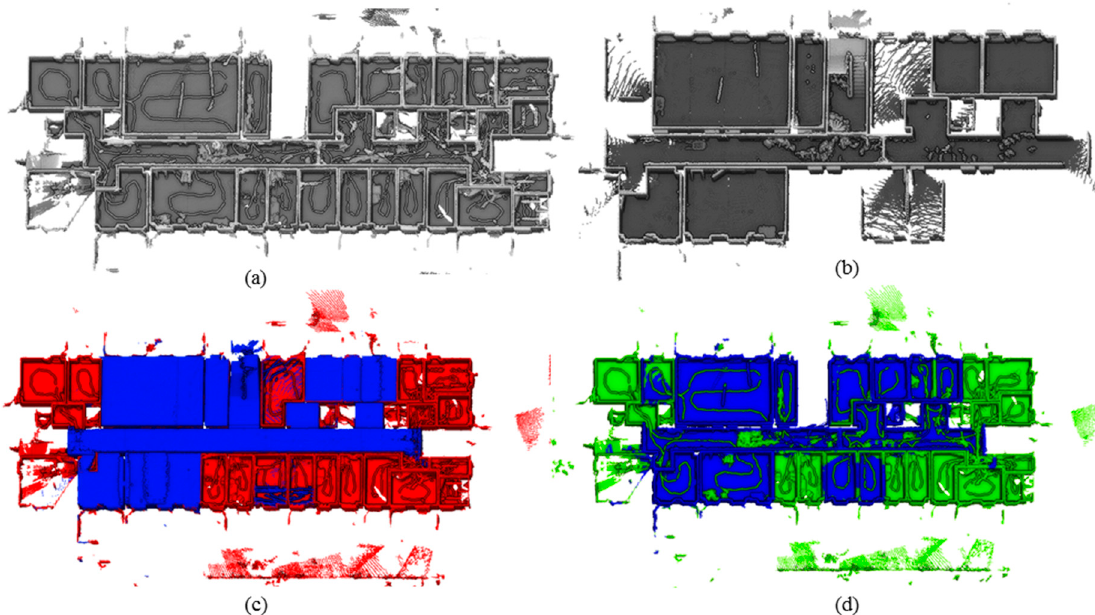
Table 1. The table shows how the point clouds are labeled regarding the changes and their role in the building structure. The points with label 1 are interesting for change detection of the 3D Cadastre. Figure 7. ( a ) Point clouds from a backpack system from the first epoch. ( b ) Point clouds from a Zeb-Revo system from the second epoch. ( c ) Co-registered point clouds. ( d ) Point clouds of epoch1 after the comparison with epoch2.